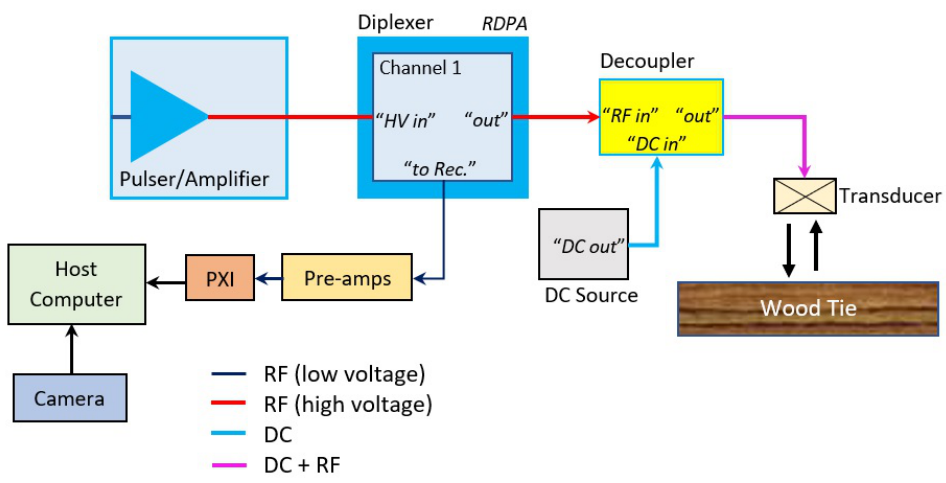
Figure 7. Schematic of data acquisition system (1 channel setup) with a